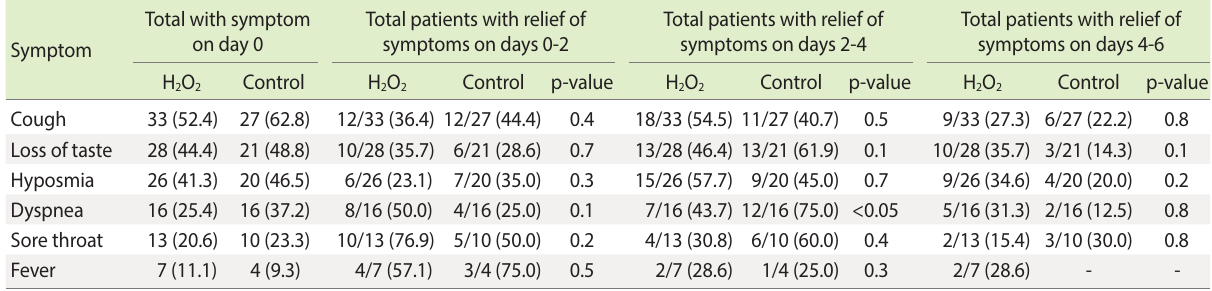
Table 2. Symptomatic individuals on day 0 who reported relief of symptoms for cough, loss of taste, hyposmia, dyspnea, sore throat, and fever over the first 6